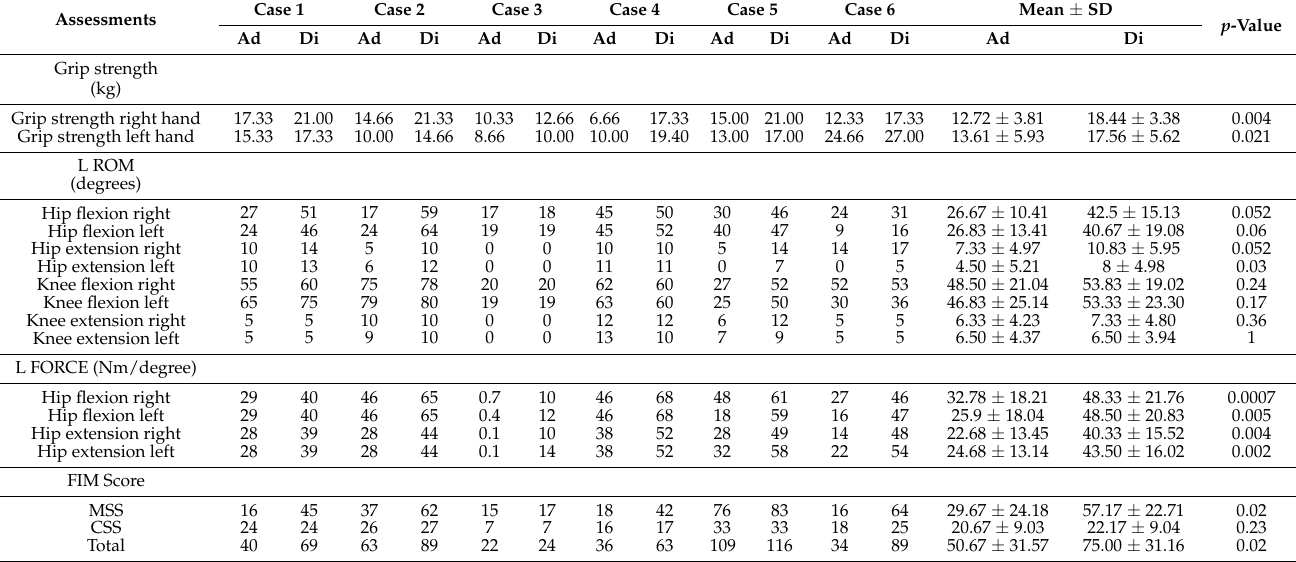
Table 3. Patients’ assessment